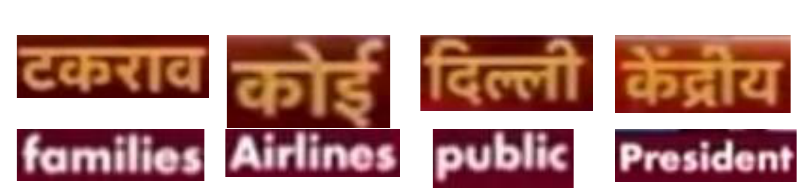
Figure 14. Example of samples shares exactly the same font and background in CVSI-15 dataset.